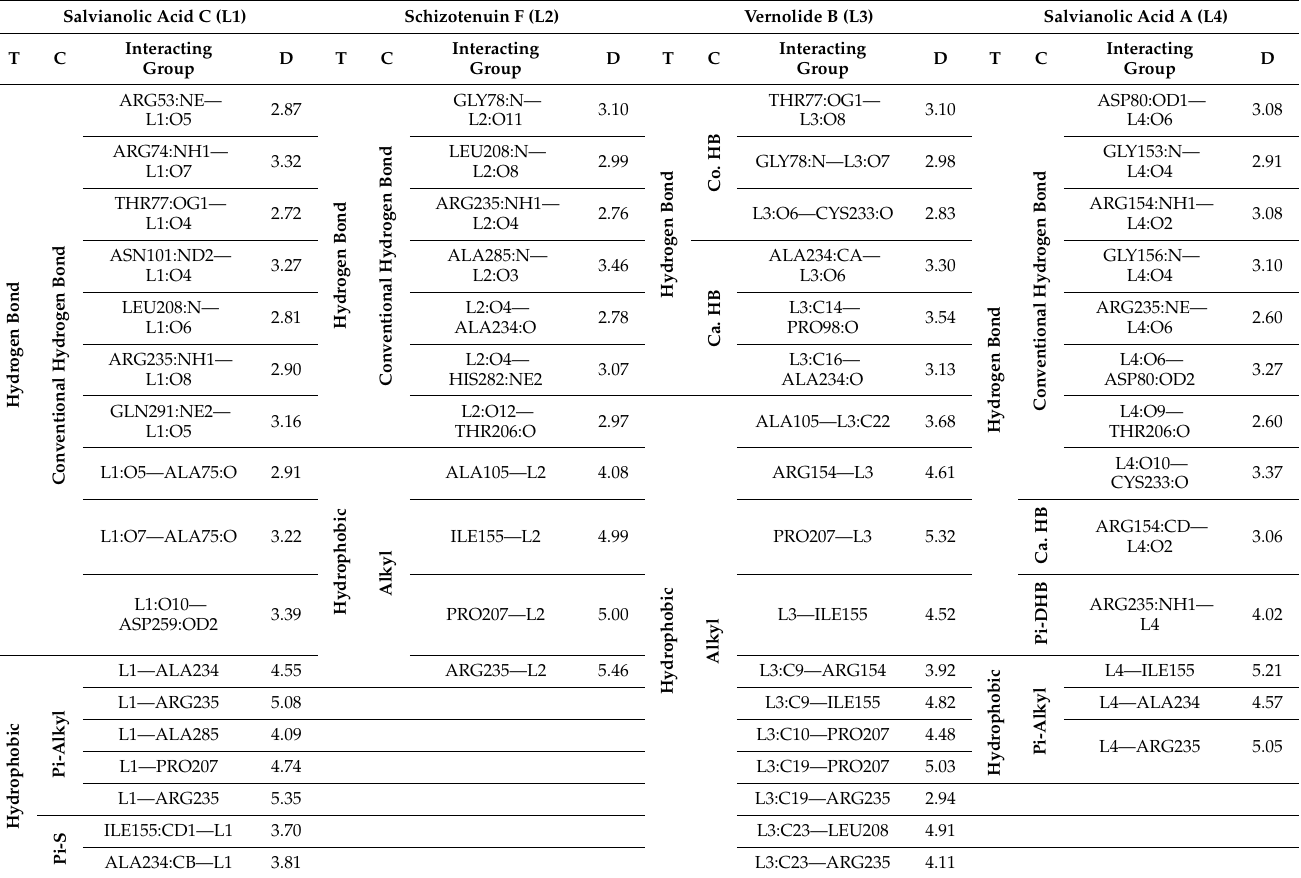
Table 2. The type of interactions and amino acids involved in the binding at the NADH binding